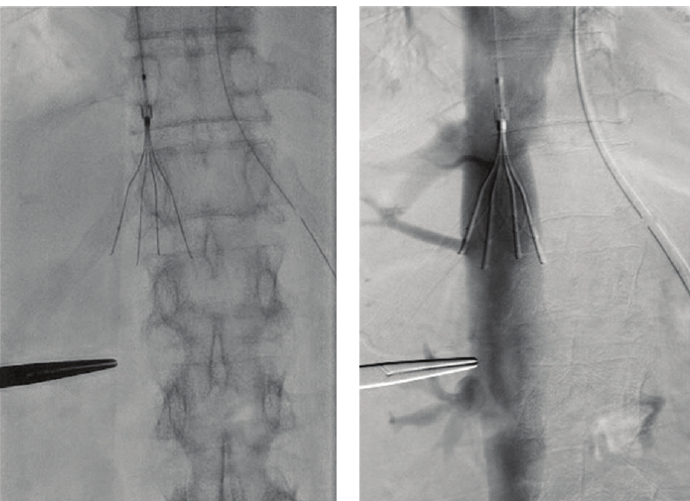
Figure 2: A transient IVC filter was implanted at the site of the suprarenal IVC via the right jugular vein. Insertion of the IVC filter was performed under angiographic and echocardiographic